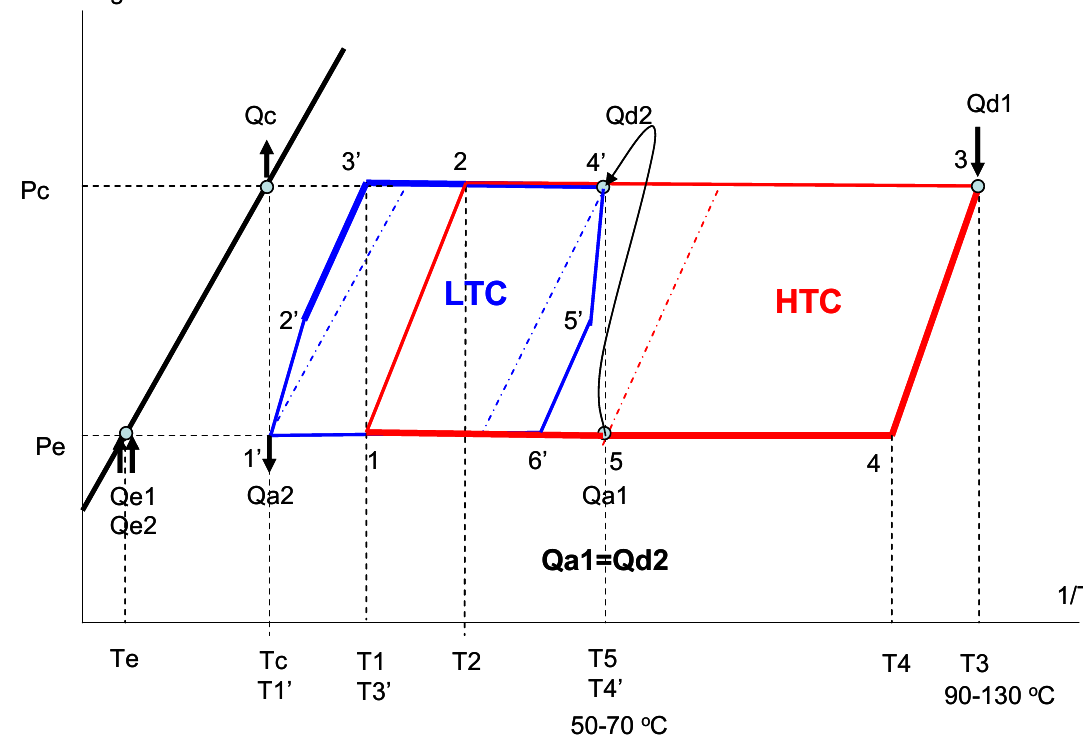
Figure 2. Ideal process of the proposed cascading cycle with mass